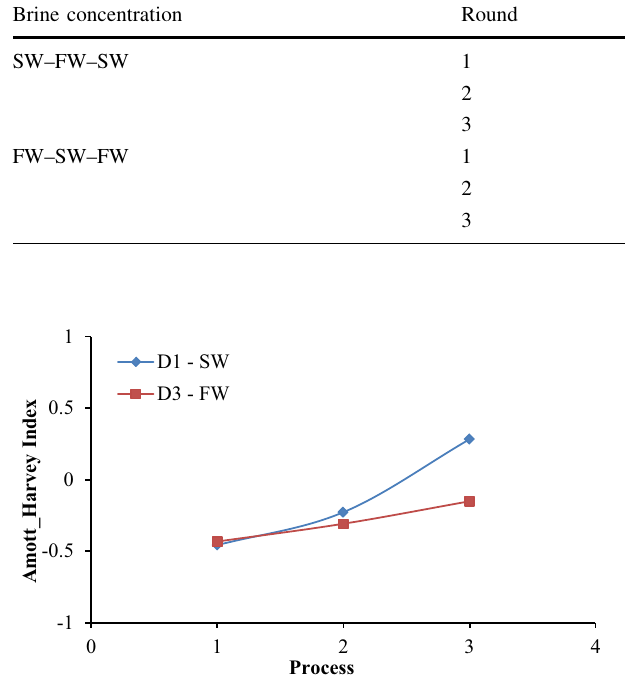
Fig. 11 Amott–Harvey wettability index for limestones started with SW and